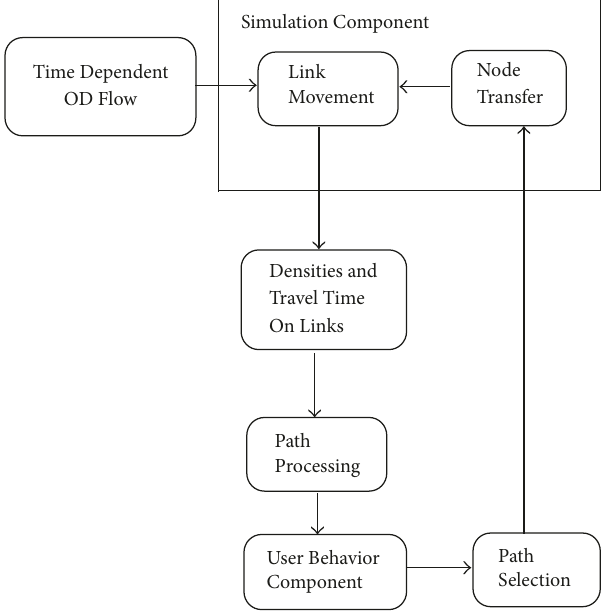
Figure 1: Dynasmart modeling framework